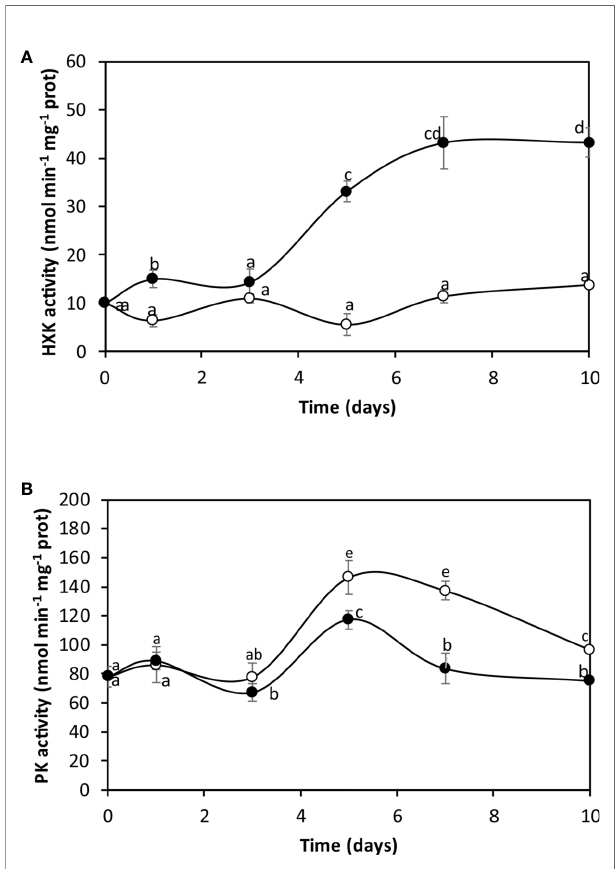
FIGURE 1 | Activities of hexokinase (HK, A ) and pyruvate kinase (PK, B ) in the alga cultivated in seawater without copper addition (open circles) and with 10 µM copper (black circles) for 0 to 10 days. Enzyme activities are expressed in nanomoles per minute per milligram of protein extract, and time in days. Symbols represent mean values of three independent experiments. Different letters indicate signi fi cant differences among mean values (±SD) ( P <